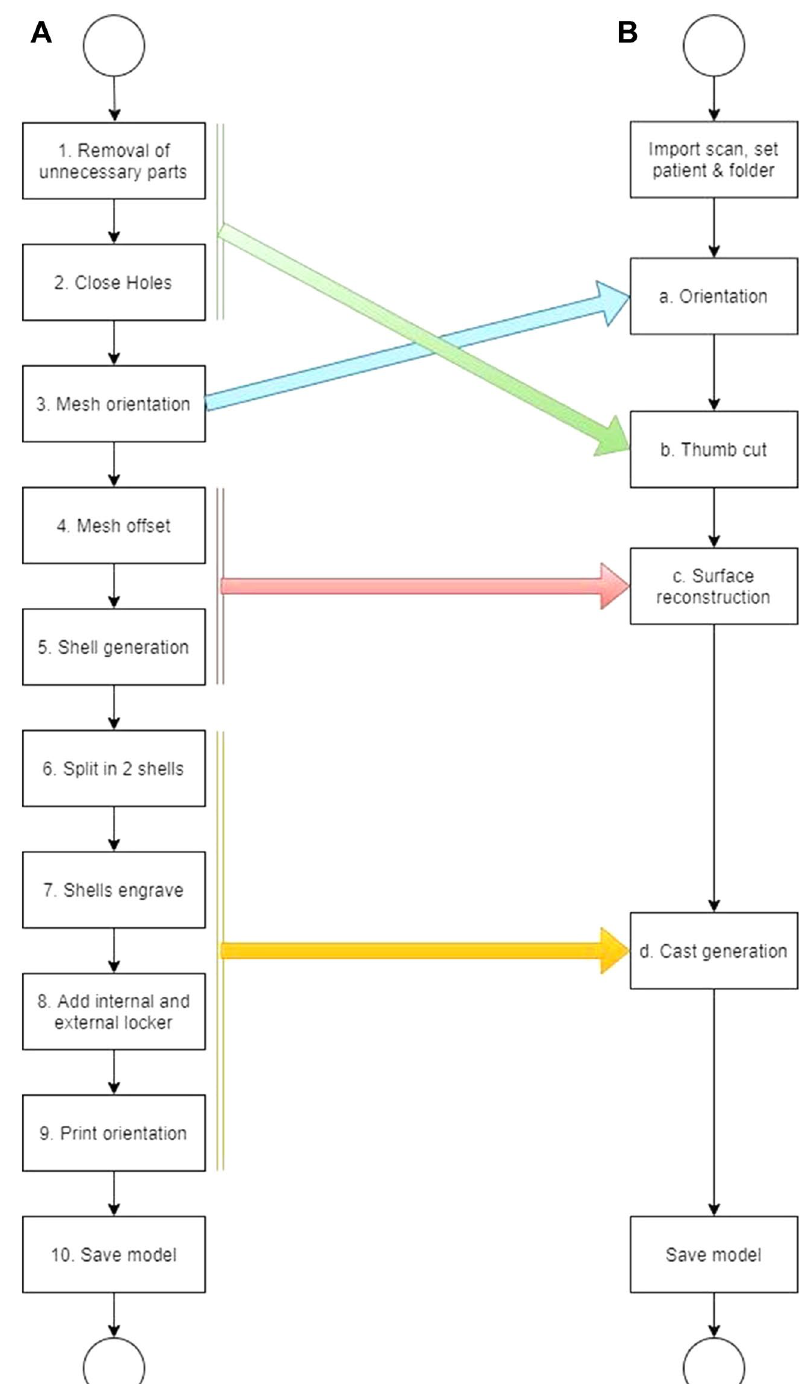
Fig. 1 General processing Workflow: A Manual pro- cedure; B Semi-automatic